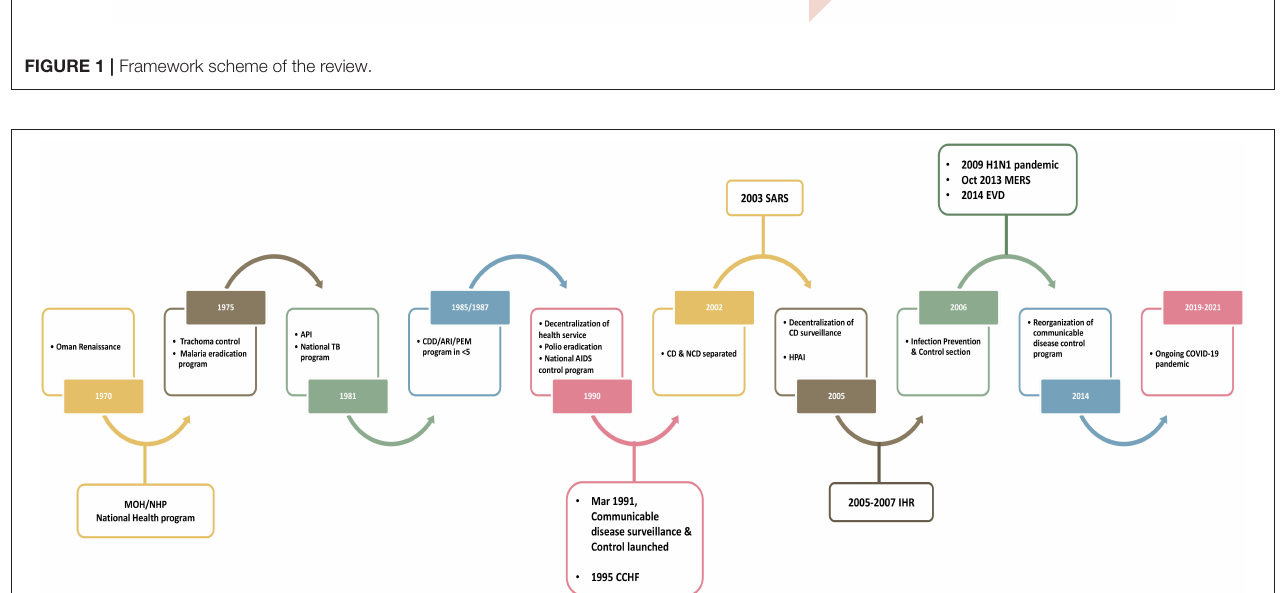
FIGURE 2 | Historical milestone of the public health services and communicable disease control in